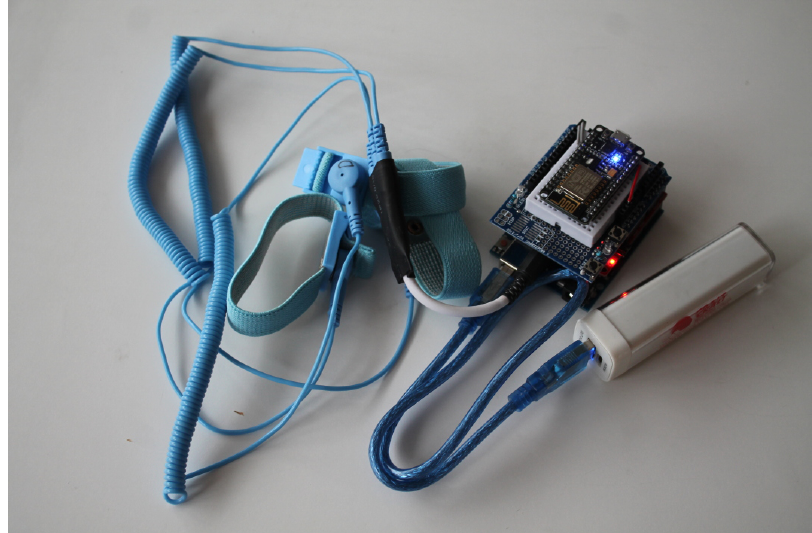
Figure 3. The patient-side prototype device, with three elastic bands, the battery, and the assembled